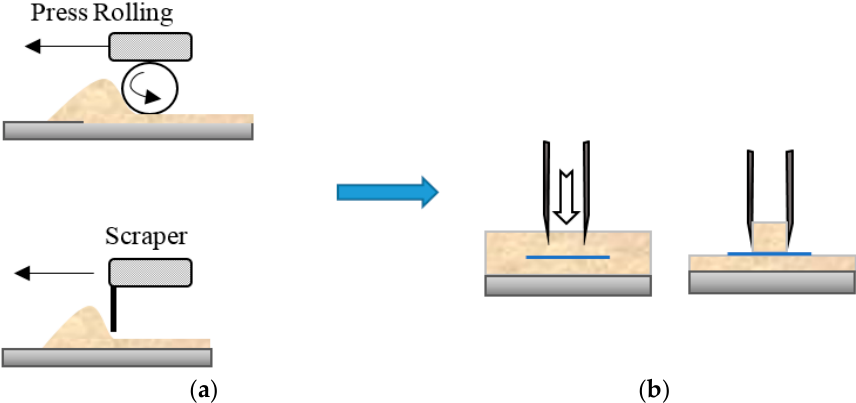
Figure 1. ( a ) Illustration of layer formation by two examined spreading tools. ( b ) Process of using a plug to sample the powder bed to measure spread density.